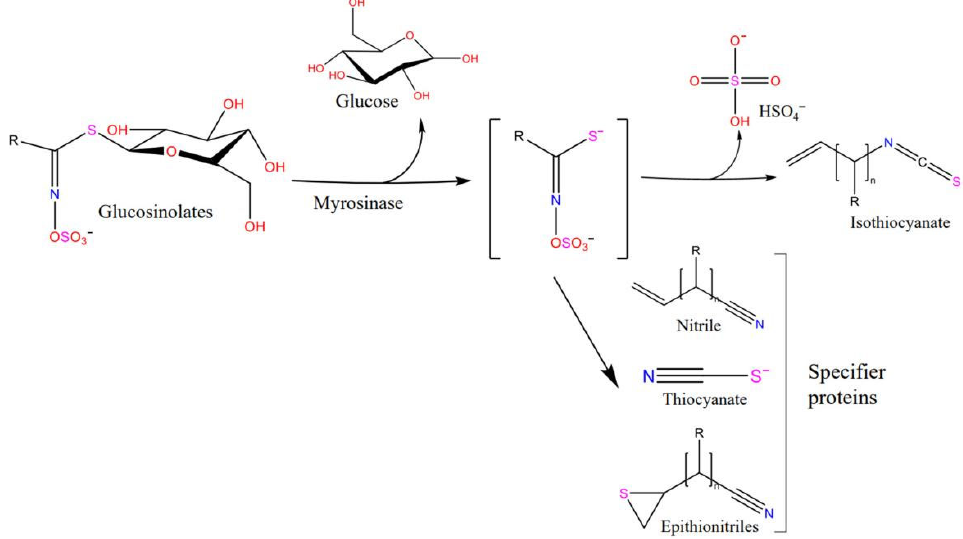
Figure 1. Generalized scheme of the hydrolysis of glucosinolates by myrosinase.